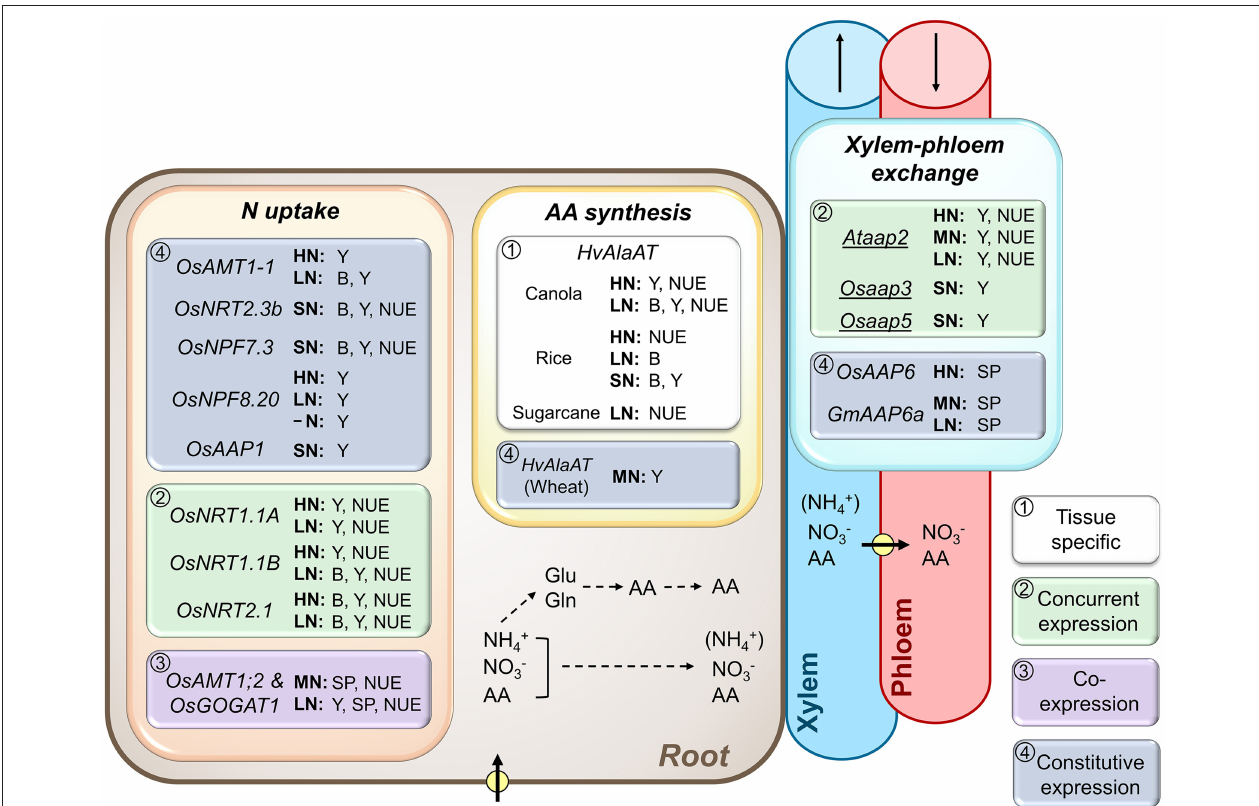
FIGURE 1 | Importance of root N transport and metabolic processes, and xylem-phloem exchange along the transport pathway for plant biomass and yield production, and N use efficiency. Shown are ammonium (NH + 4 ), nitrate (NO − 3 ), and amino acid (AA) transporters, and AA synthesis genes that were successfully overexpressed ( UPPERCASE ) or repressed/knocked out ( lowercase and underlined ) and resulted in increased biomass (B), seed yield (Y), seed protein (SP), and/or plant N use efficiency (NUE) at varying N supply. As indicated by framed white, green, purple, or blue backgrounds, the transgenic strategies used either (1) tissue-specific gene manipulation, (2) concurrent expression of a particular gene in both root and shoot tissues ( OsNRT1.1A , Wang et al., 2018b; OsNRT1.1B , Hu et al., 2015 ; OsNRT2.1 , Chen et al., 2016), (3) co-expression of two genes in root and shoot tissues ( OsAMT1;2 and OsGOGAT1 , Lee et al., 2020a), or (4) constitutive gene expression throughout the plant. Positive results were achieved with (a) native expression of ammonium transporters ( OsAMT1-1 , Ranathunge et al., 2014; OsAMT1;2 , Lee et al., 2020a), nitrate transporters ( OsNRT1.1A , Wang et al., 2018b; OsNRT1.1B , Hu et al., 2015; OsNRT2.1 , Chen et al., 2016; OsNRT2.3b , Fan et al., 2016b ; OsNPF7.3 , Fang et al., 2017; OsNPF8.20 , Fang et al., 2013), and amino acid transporters ( OsAAP1 , Ji et al., 2020; OsAAP6 , Peng et al., 2014; GmAAP6a , Liu et al., 2020) in rice ( Os ), Arabidopsis ( At ), and soybean ( Gm ), (b) expression of a barley alanine aminotransferase ( HvAlaAT ) in canola (Good et al., 2007 ), rice (Shrawat et al., 2008; Beatty et al., 2013), sugarcane (Snyman et al., 2015), and wheat (Peña et al., 2017), and (c) by knocking out native/endogenous genes ( Ataap2 , Perchlik and Tegeder, 2018; Osaap3 , Lu et al., 2018; Osaap5 , Wang et al., 2019). Plants were grown under high (HN), moderate (MN), sufficient (SN; N supply was not specified) and low N (LN), or without N (-N). Pathways of N uptake and xylem-phloem transfer (arrows with circle), as well as N assimilation into glutamate (Glu) and glutamine (Gln), and the subsequent synthesis of other AA and their loading into the xylem are indicated. NH + 4 may be transported in the xylem to the shoot, but in relatively low amounts (indicated by brackets). Arrows in xylem and phloem indicate the direction of translocation. For additional information see manuscript